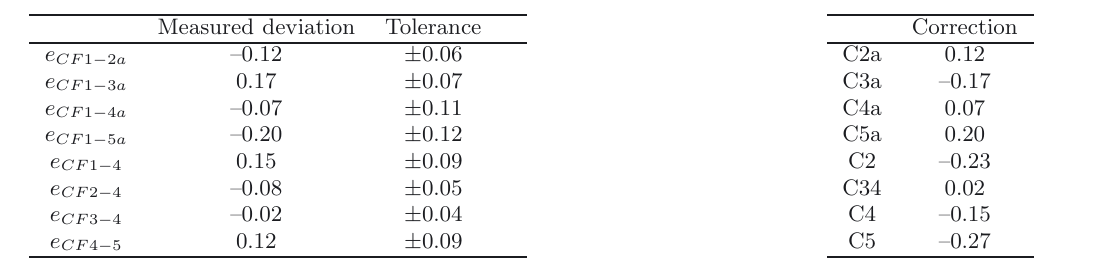
Table 3. Theoretical corrections to the correctors and to the tool